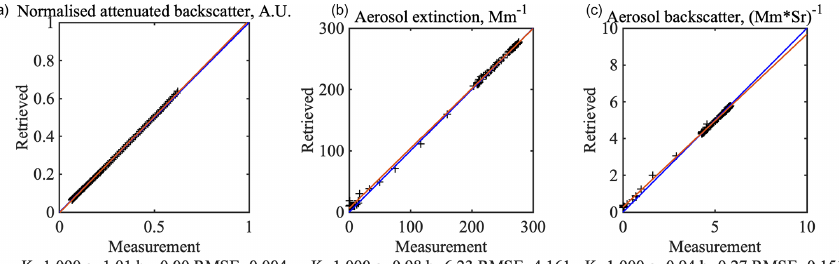
Figure 36. Achieved fits for attenuated inelastic backscatter at 387nm (a) , aerosol extinction at 532nm (b) and aerosol backscatter at 532nm (c) ; data acquired on 16 April